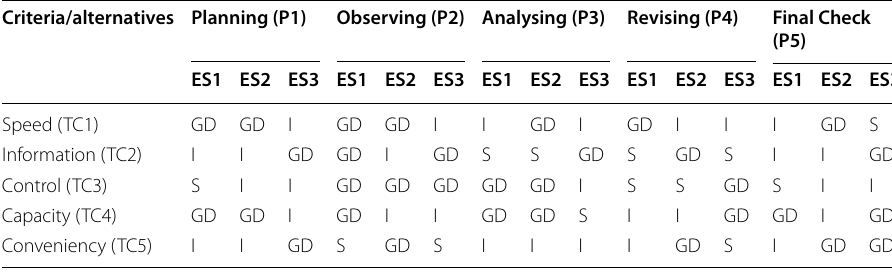
Table 21 LEs for the phase 2 of QFD Criteria/alternatives Planning (P1)